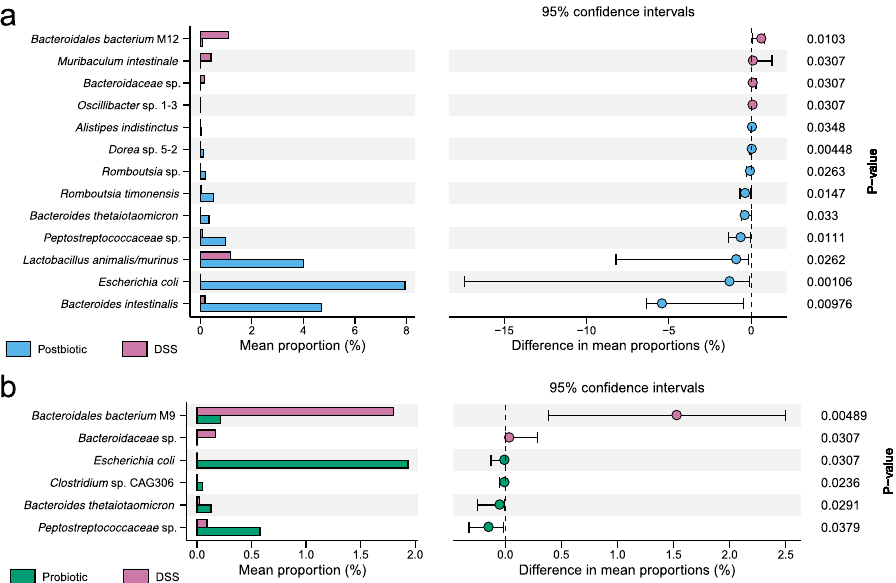
Fig. 4 Postbiotics had a stronger effect on the gut microbiota composition in DSS-induced colitis mice compared with probiotics. The differential species between the Postbiotic group and Dextran sulfate sodium (DSS) group ( a ) and between the Probiotic group and DSS group ( b ), evaluated by Wilcoxon rank-sum